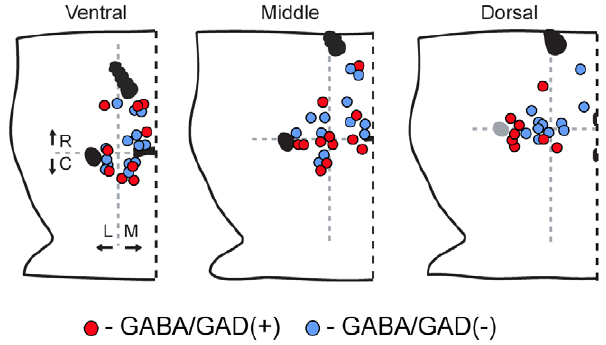
Figure 3. Locations of recorded VTA GABA neurons. Sample includes neurons throughout the VTA. Schematic diagrams of ventral, middle, and dorsal horizontal slices containing the VTA. (R: rostral; C: caudal; M: medial; L: lateral).